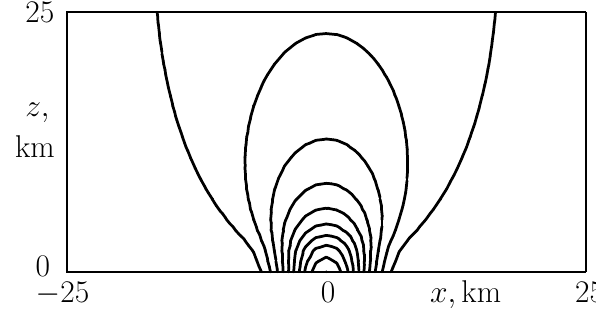
about 3% of the total vertical current is closed inside the atmosphere for a = 400 km and about 30% for a = 100 km (Fig. 7). For a source size dimension of a = 10 km, the hori- zontal resistivity is much less than the vertical one and only about 20 % of current reaches ionospheric heights (Fig.